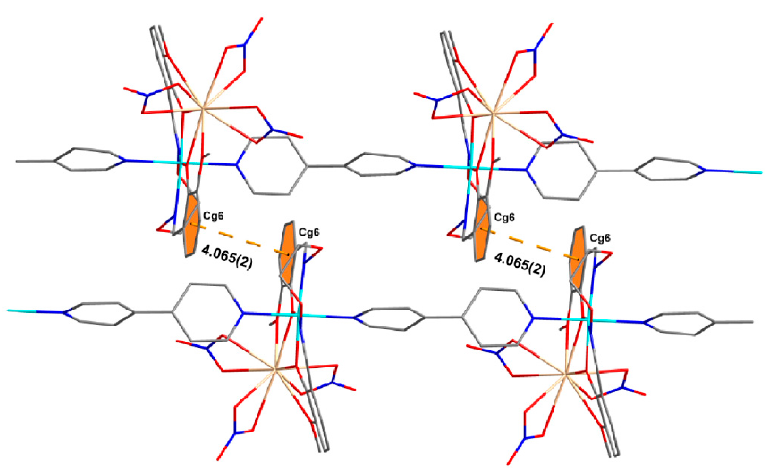
Figure 6. View of one-dimensional chain-like structure of the title polymer.